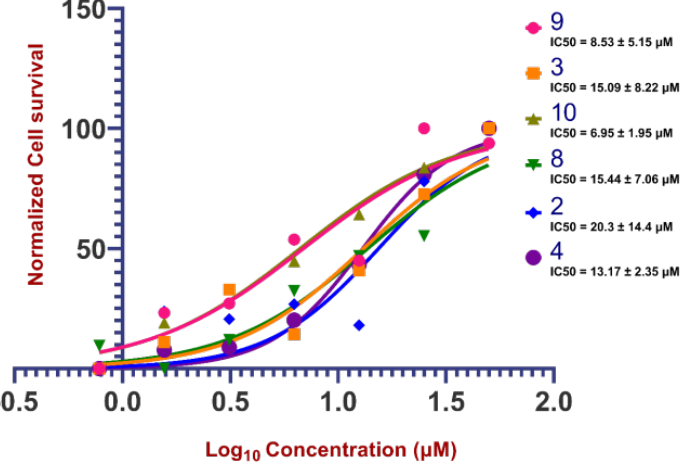
Figure 4. Dose response anti-viral testing: Top performing compounds from initial testing display- ing statistically significant inhibitory efficacy against SARS-CoV-2 (alpha strain, SARS-CoV-2, USA- WA1/2020), in a dose-dependent manner. Vero cells, and kidney epithelial cells were treated at var- ious serially-diluted concentrations of compounds, and cell viability was measured versus a DMSO control at 24 h post-treatment as described in the methods.